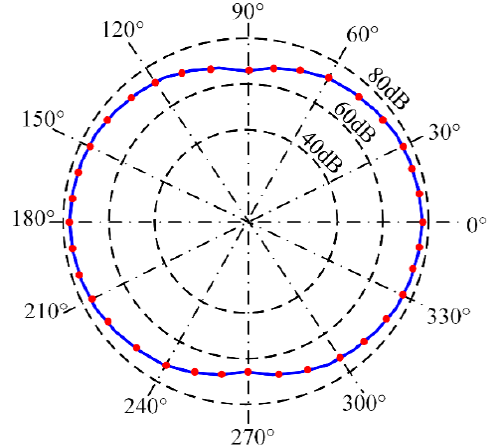
Figure 8. Polar diagram of the FBG AE sensor signal amplitude.